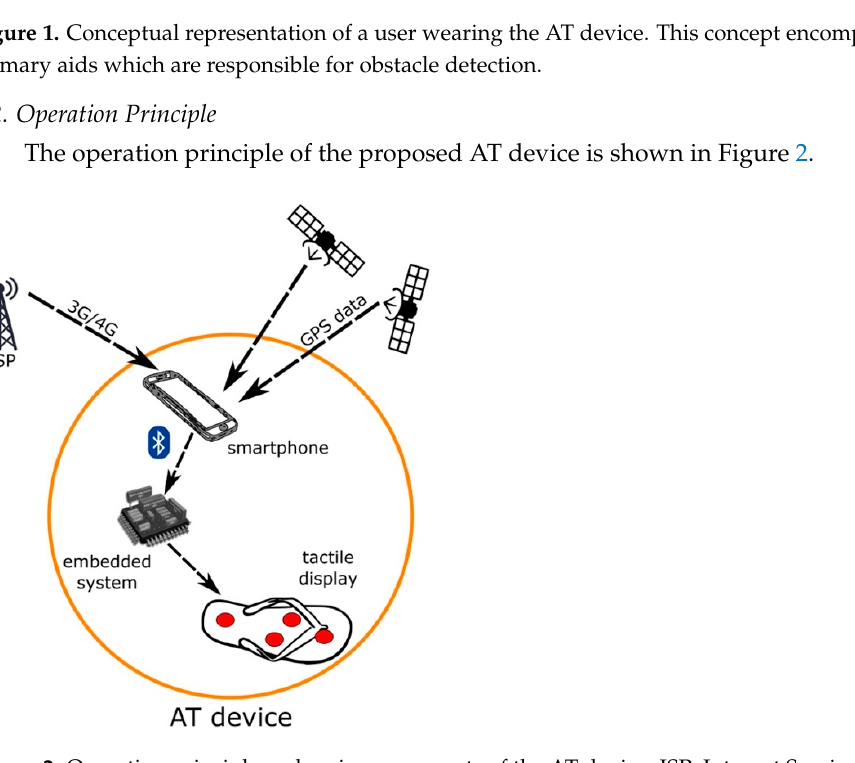
Figure 2. Operation principle and main components of the AT device. ISP: Internet Service Pro- vider.